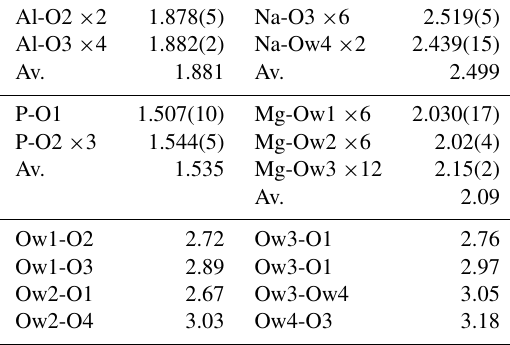
Table 5. Polyhedral bond lengths [Å] and likely H-bonded anions in